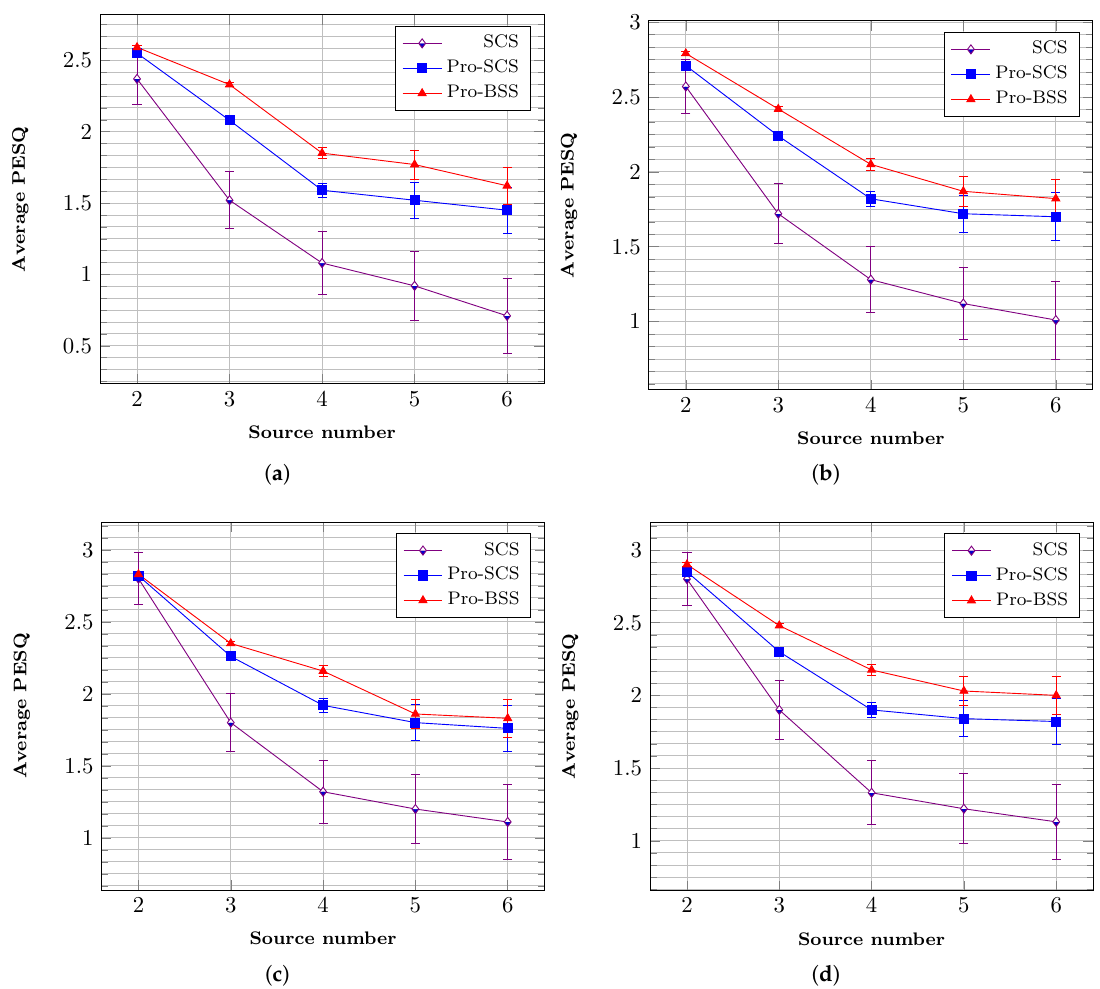
Figure 10. PESQ results. Error bars represent 95% confidence intervals, ( a – d ) represent the results for separations {30 ◦ , 40 ◦ , 50 ◦ , 60 ◦ }, SNR = 20 dB, RT 60 = 0.5